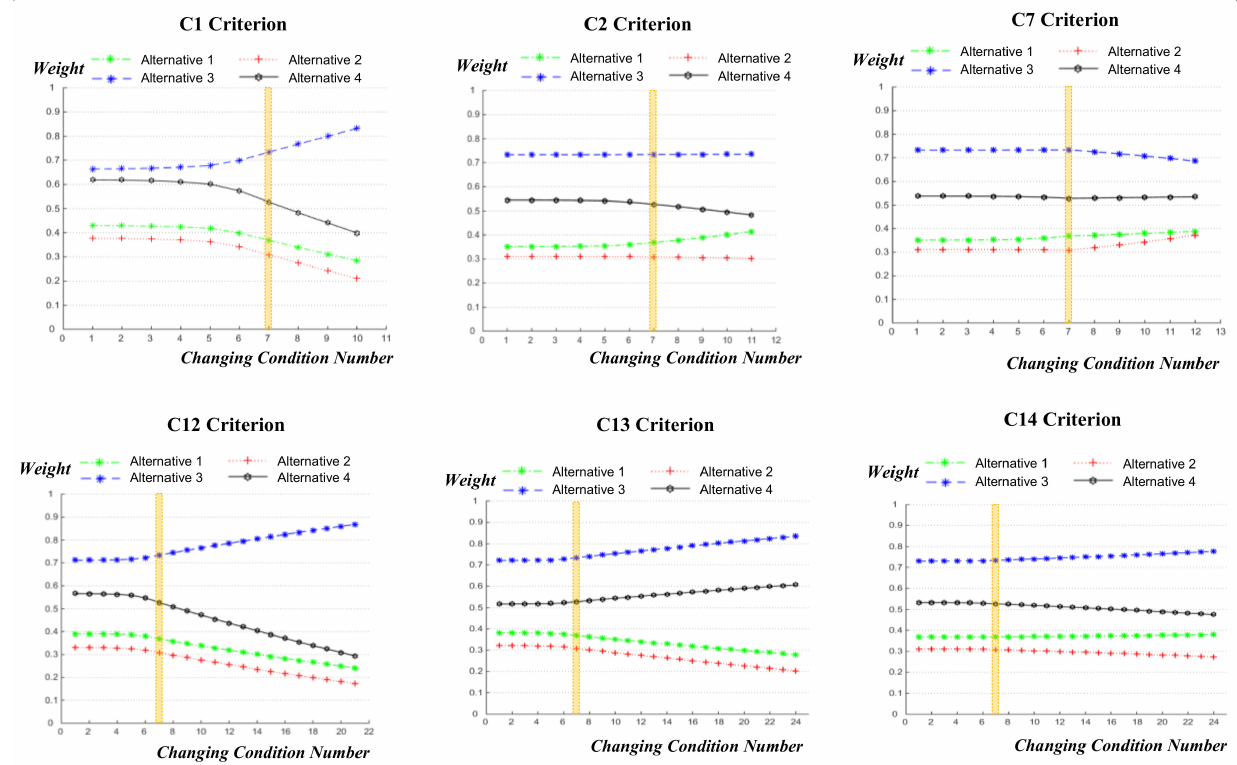
Figure 6. Sensitivity analysis results of sub-criteria C1, C2, C7, C12, C13 and C14.